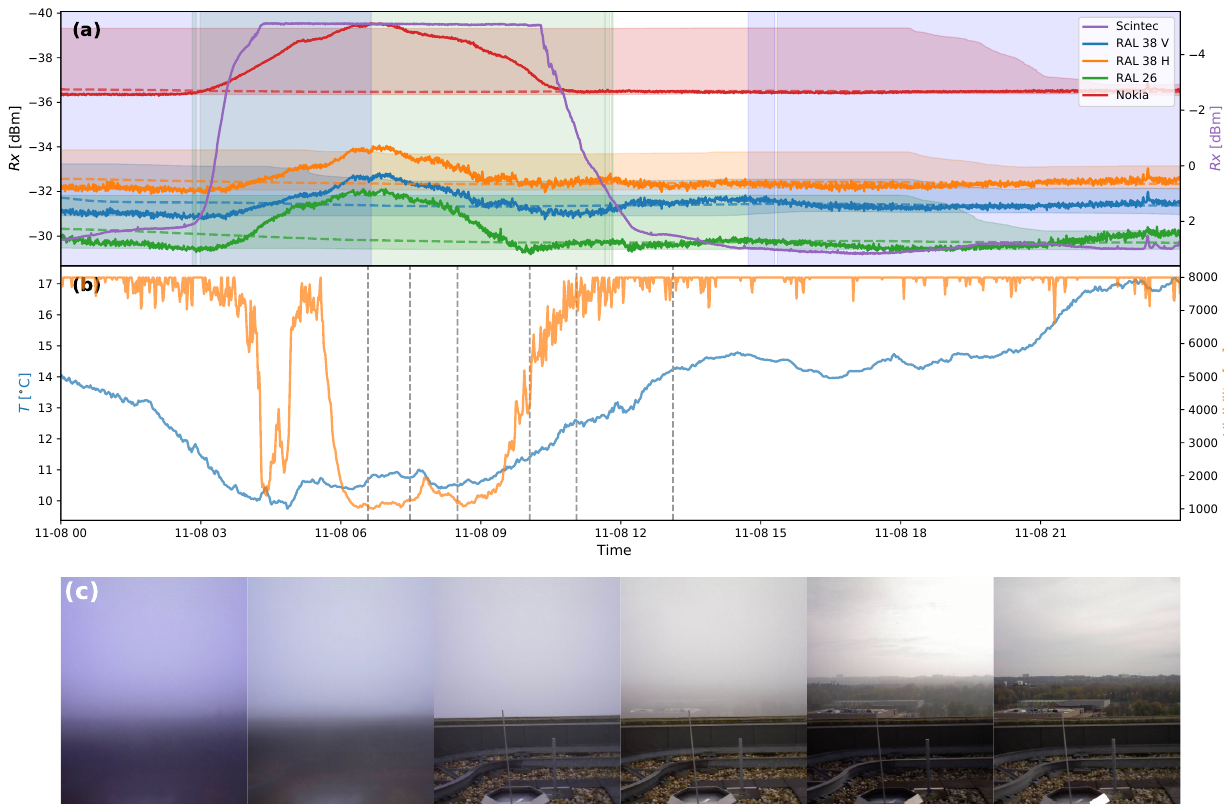
Figure 12. Time series of an event on 8 November 2015. (a) Received power levels at the detectors (solid lines) and reference levels (median over dry periods in a 24h moving window: dashed lines). Periods with a negative net radiation flux at the surface are indicated with blue shading. Periods with a relative humidity > 90% are indicated with green shading. (b) Several atmospheric variables measured at the “Veenkampen” meteorological station: visibility and ambient air temperature at 2m indicated with orange and blue lines, respectively. (c) Images from the time-lapse camera at the location of the receiving antennas aimed along the link path. The times at which these images were captured are indicated by the vertical dotted